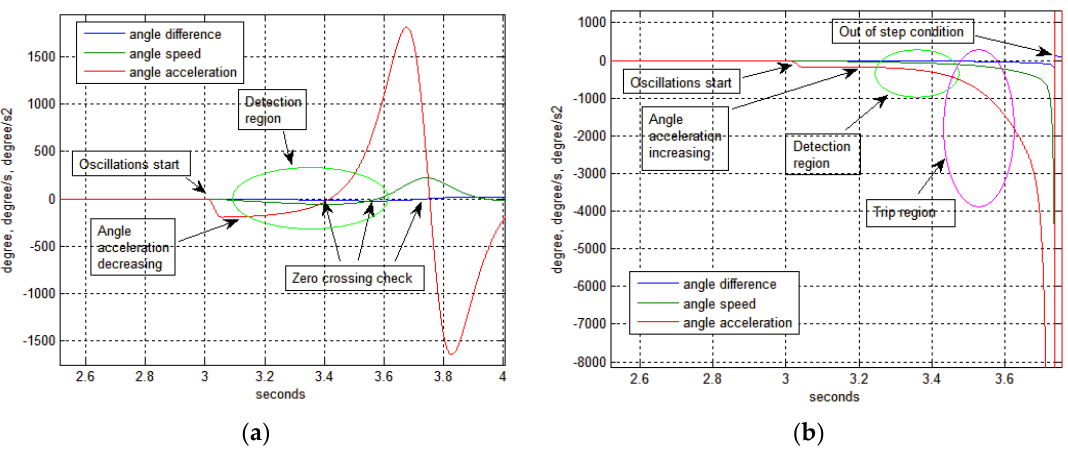
Figure 12. Details for power swing condition and out-of-step conditions on 400 kV line: ( a ) Details of the voltage angle difference Δ φ , angle speed ω and angle acceleration α , on 400 kV transmission line with stable swing condition; ( b ) Details of the voltage angle difference Δ φ , angle speed ω and angle acceleration α , on 400 kV transmission line with out-of-step conditions.